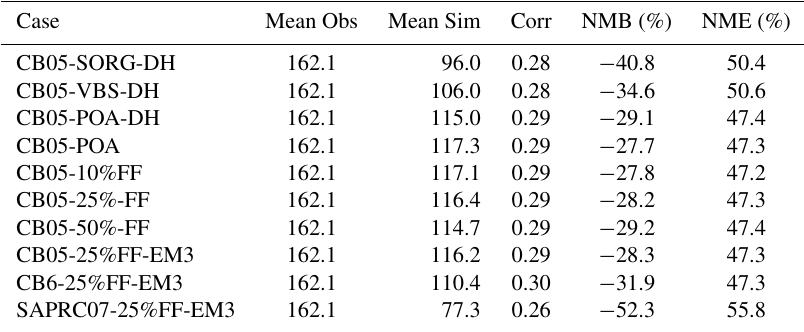
Table 8. Statistics for model evaluation for simulated CDNC against MODIS-derived CDNC from Bennartz (2007). All cases use the Grell– Freitas cumulus